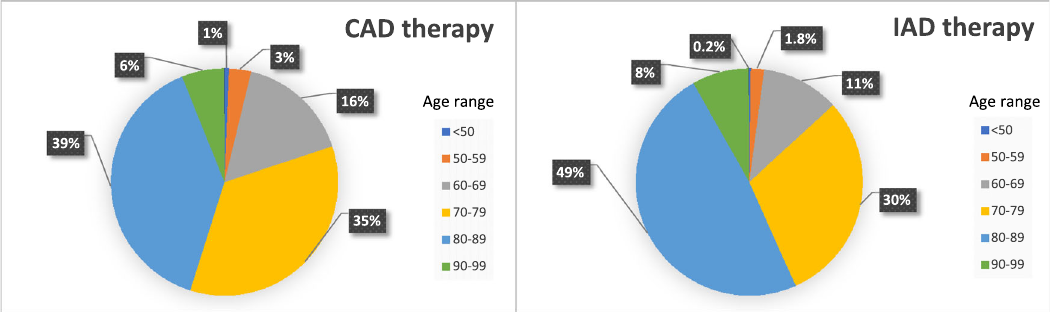
Figure 4. Age distribution of prostate cancer patients under IAD or under